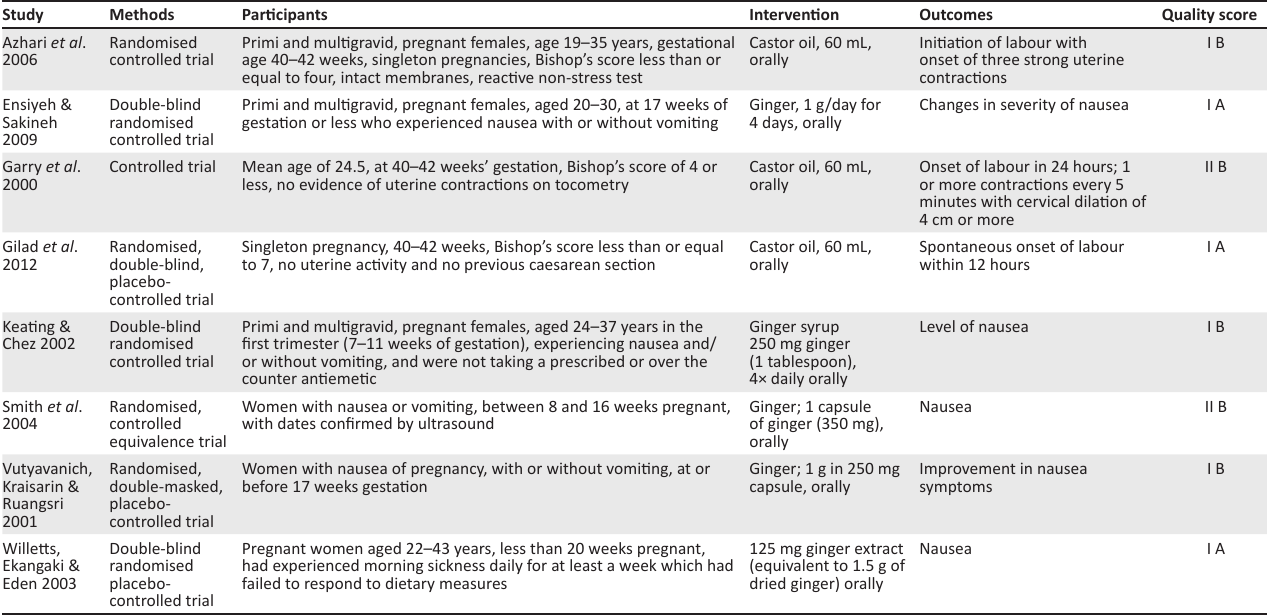
TABLE 1: Characteristics of included studies.